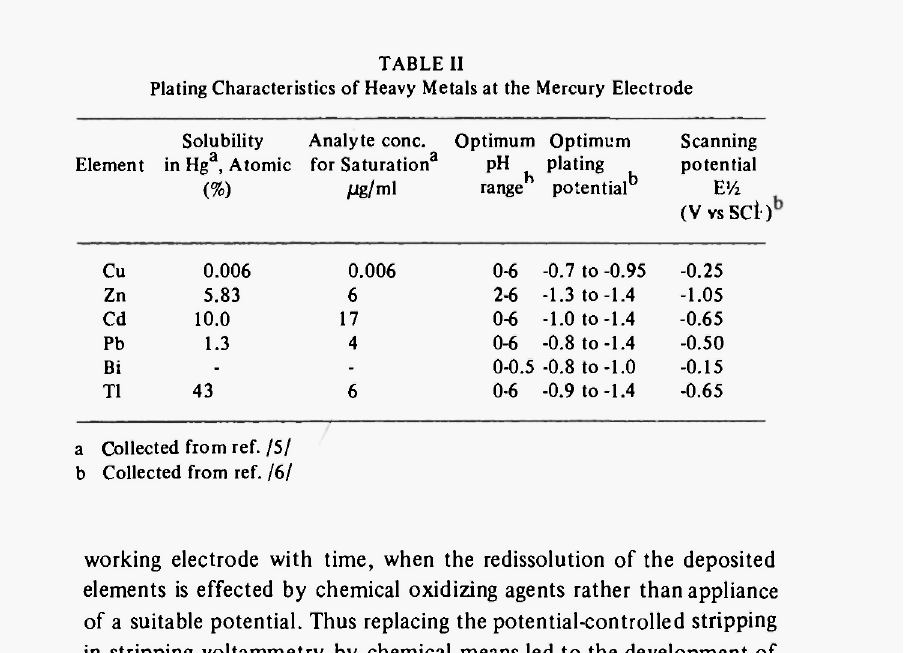
TABLE II Plating Characteristics of Heavy Metals at the Mercury